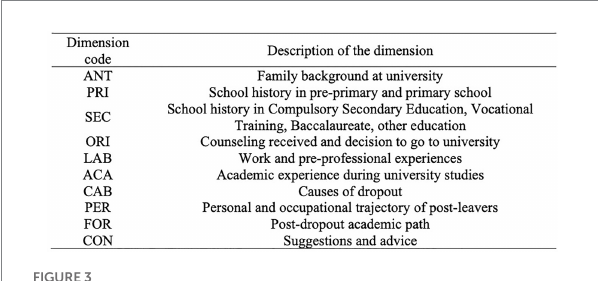
FIGURE 3 Biographical interview applied to dropout